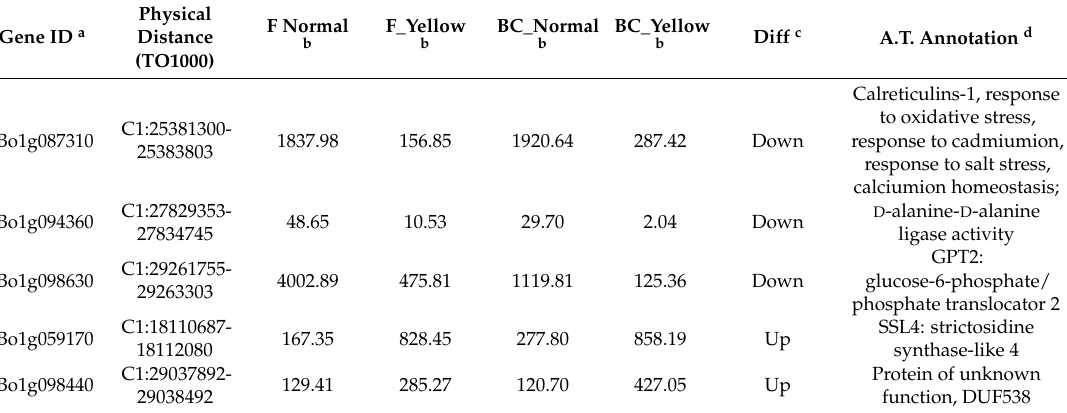
Table 3. DEGs related to chloroplasts in the recombination-suppressed